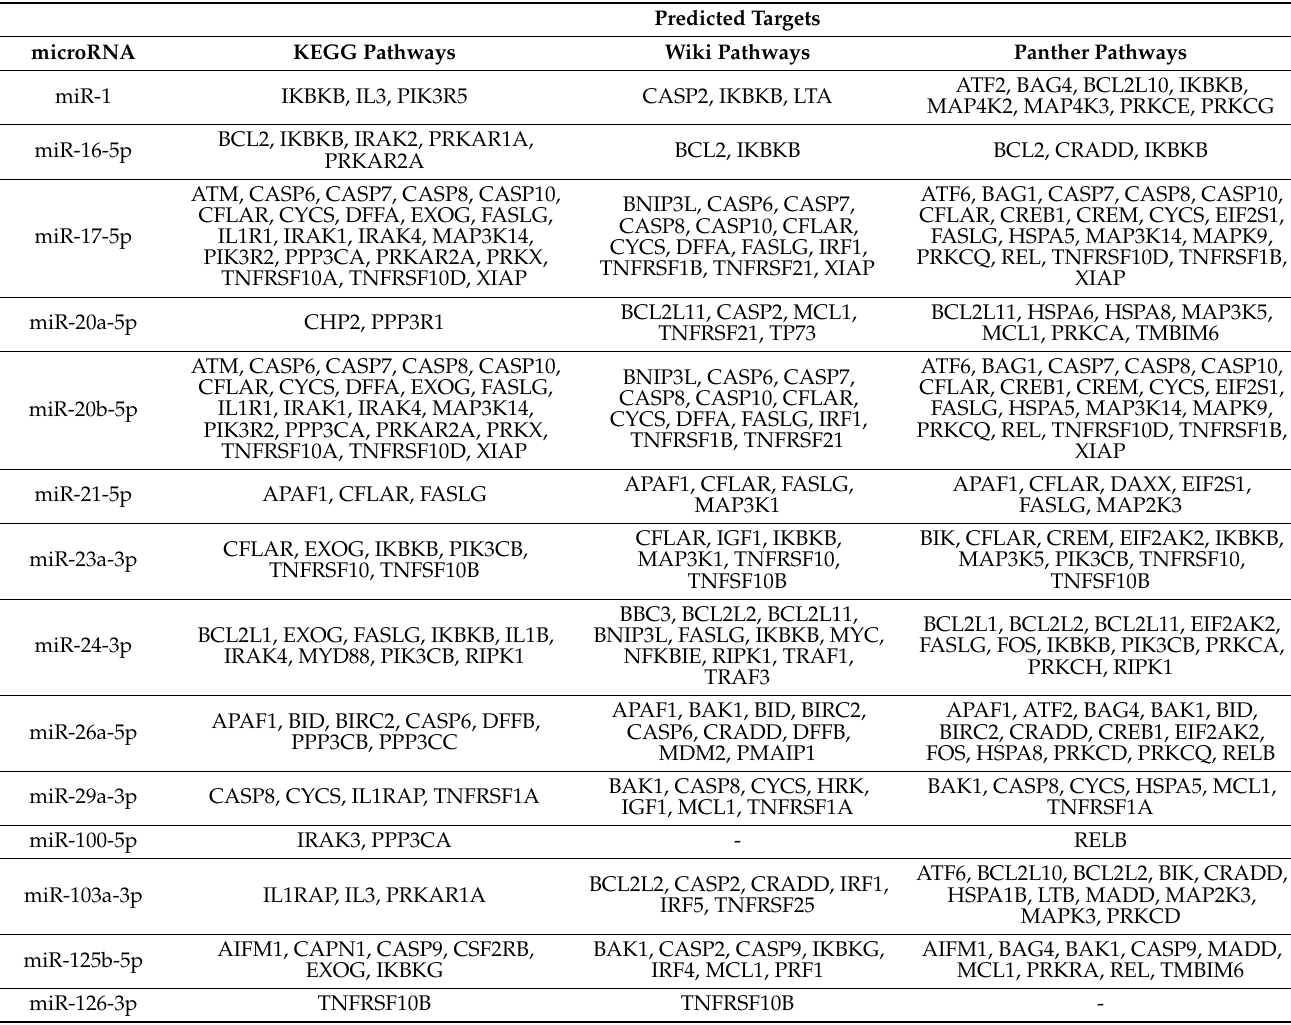
Table 5. A list of predicted targets of microRNAs dysregulated in the whole peripheral blood of preterm-born children in relation to the apoptosis pathway, using the miRWalk2.0 database (data available in the KEGG, Wiki, and Panther